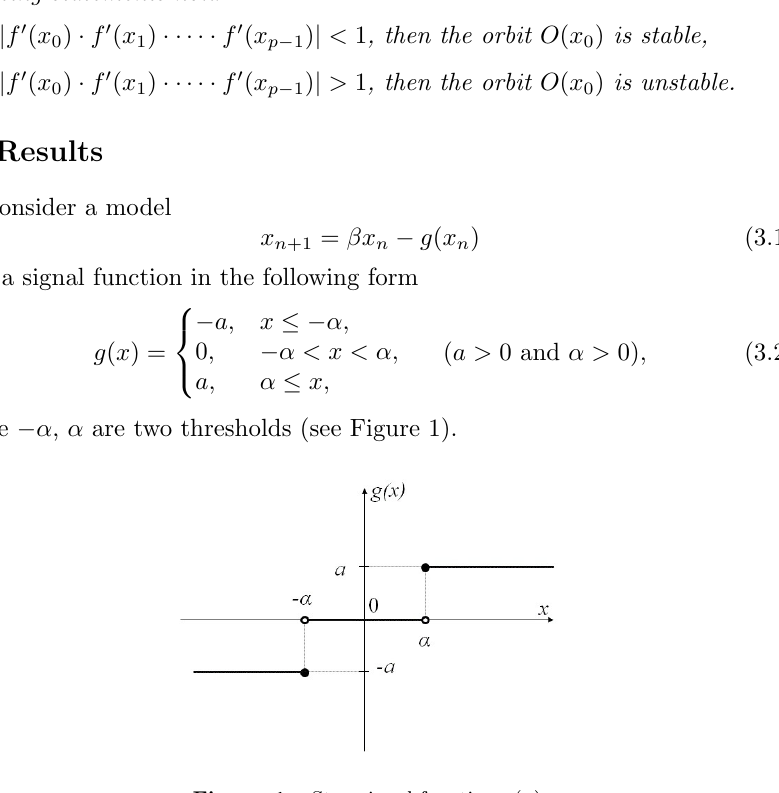
Figure 1. Step signal function g ( x